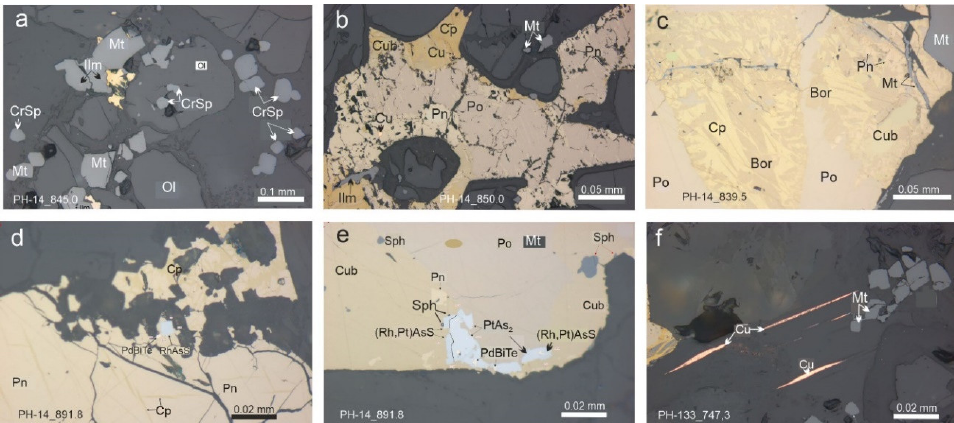
Figure 4. Microparageneses of the minerals in the picritiс gabbro-dolerite: ( a ) PH-14_845.0; ( b ) PH-